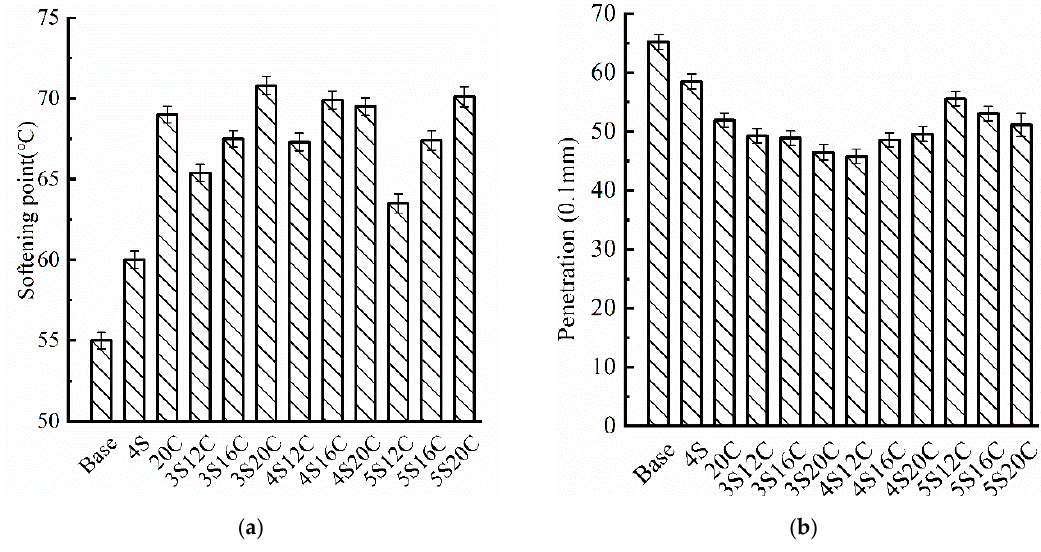
Figure 2. Basic physical properties testing results: ( a ) softening point, and ( b ) penetration.